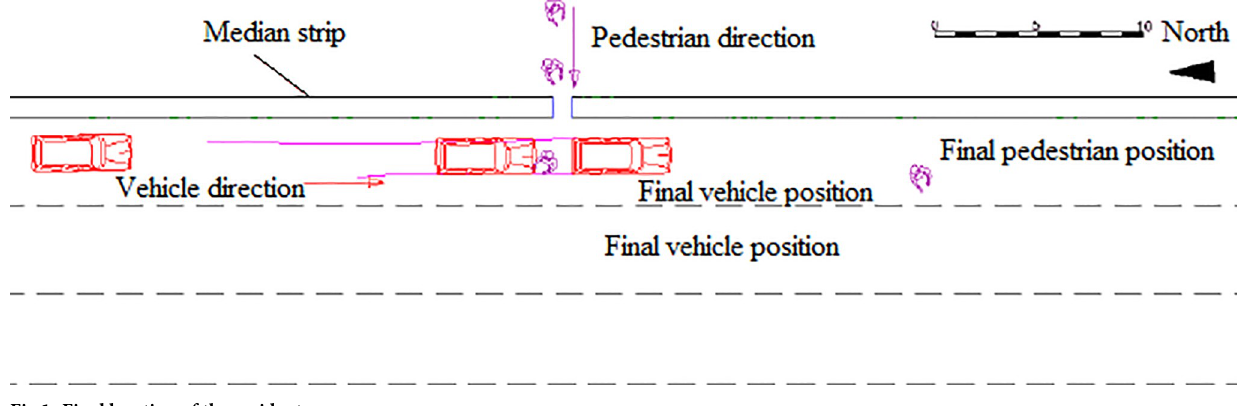
Fig 1. Final location of the accident.